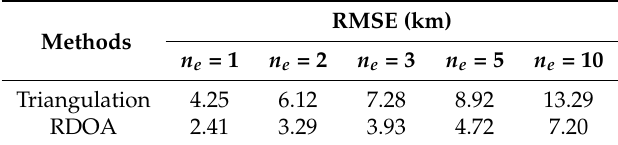
Table 1. RMSE comparison for various measurement noises ( n e